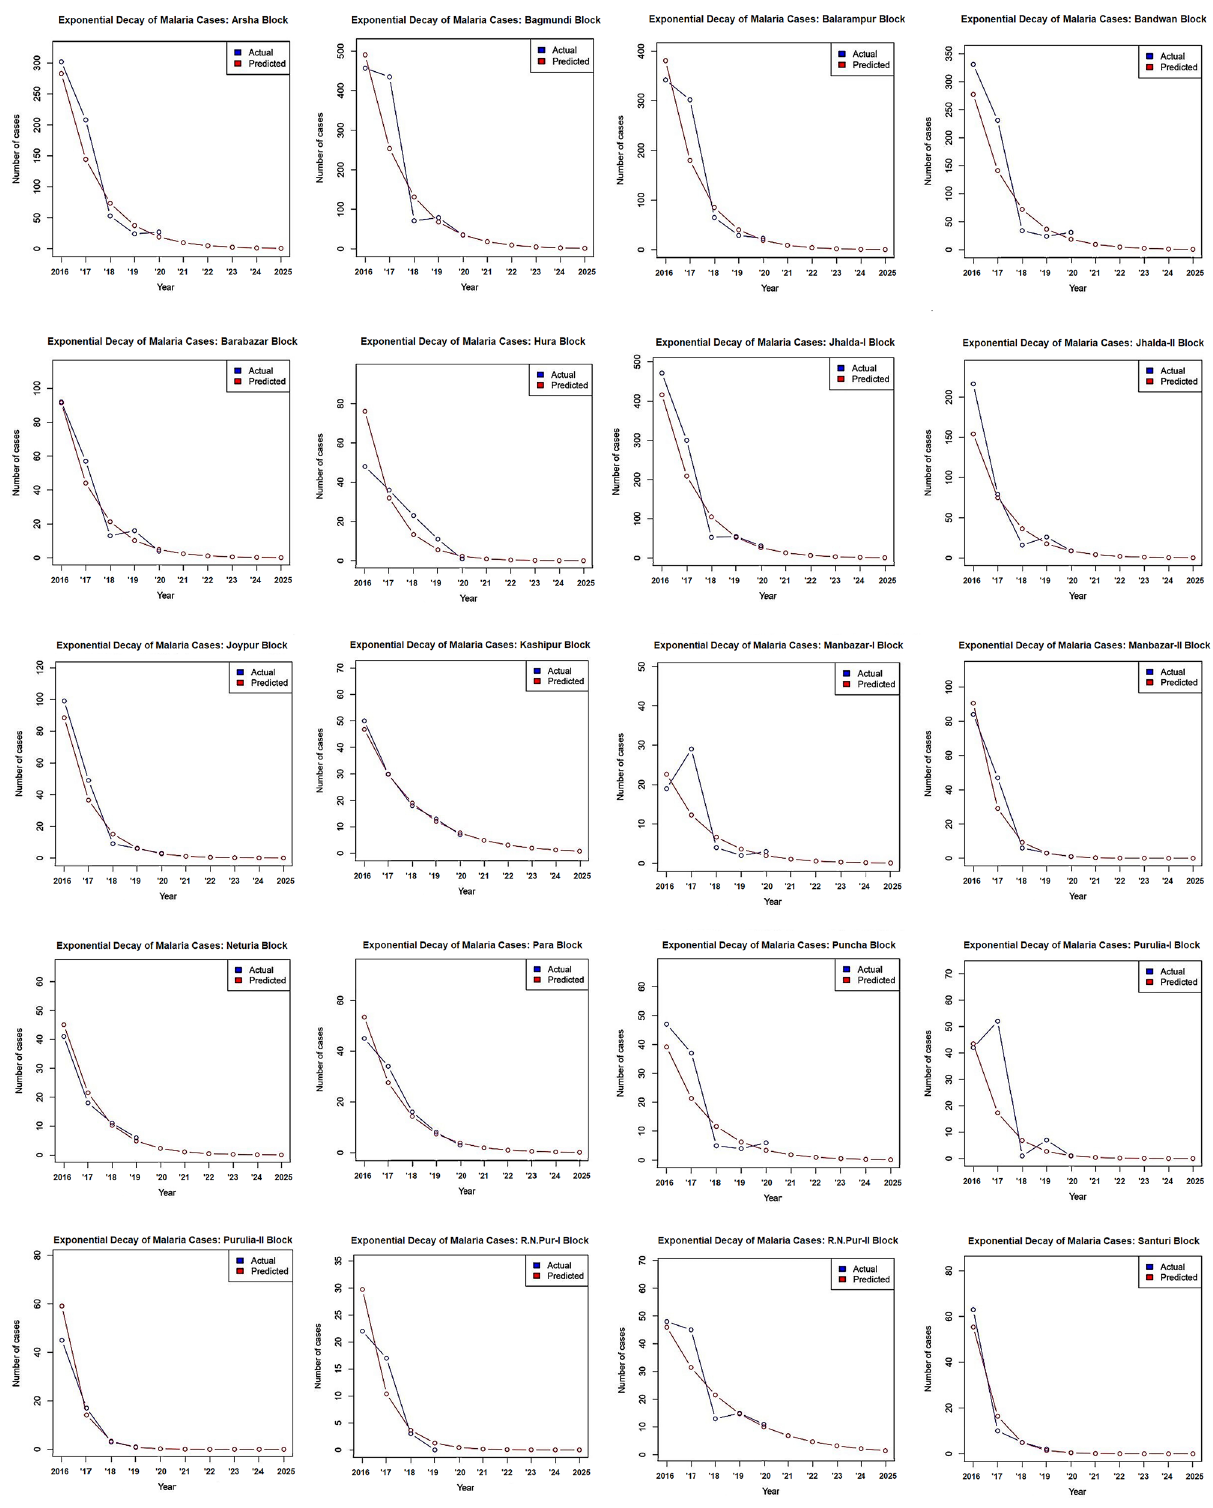
Figure 3. Predictions of malaria cases from 2016 to 2025 via exponential decay model analysis while assuming other factors (e.g., environmental factors etc.) are constant throughout the study period. These plots were created with “R” statistical software using version 3.4.1 (R Foundation for Statistical Computing, Vienna, Austria, 2017. https:// www.R- proje ct.